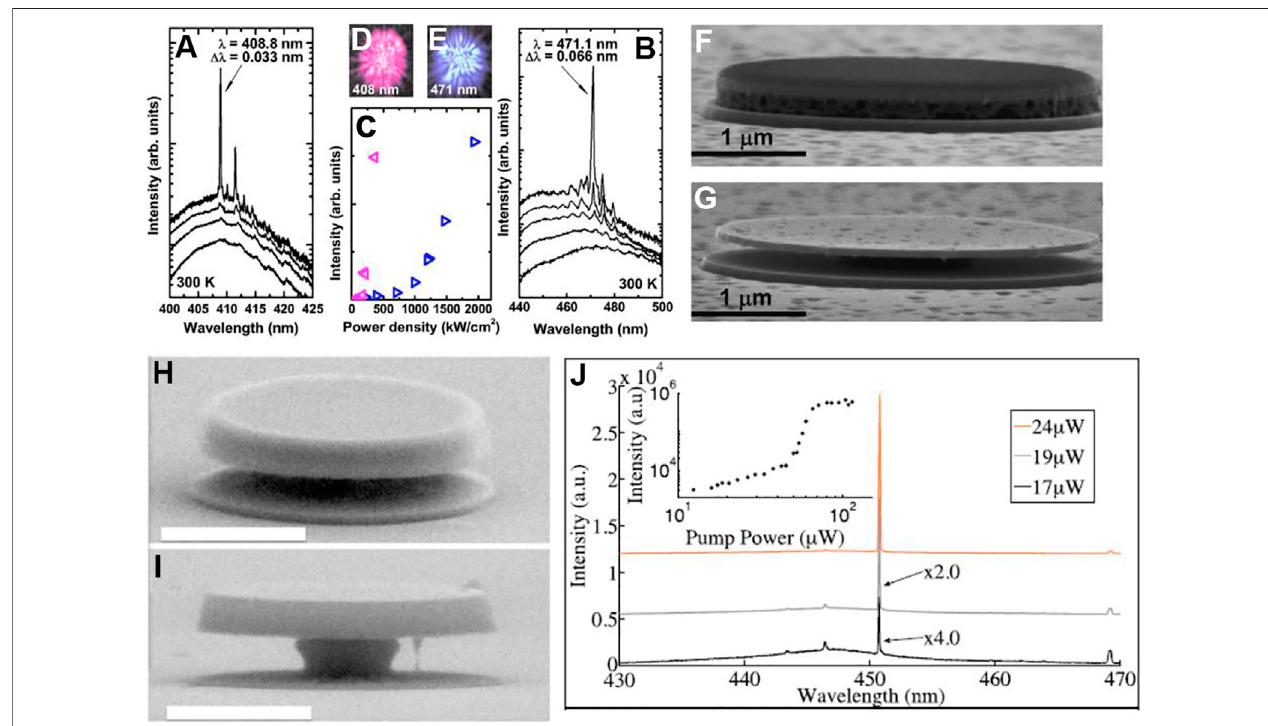
FIGURE 4 | Lasing properties of GaN microcavities (Simeonov et al., 2008), reprinted with permission © AIP Publishing (Simeonov et al., 2008). Lasing spectra of GaN microcavities with (A) low and (B) high In content. (C) Threshold curves of GaN microcavities. Optical microscopy images with false color (D,E) . SEM images of AlGaN (F) before and (G) after removal of the oxidation sacri fi cial layer. Lasing properties of fl oating GaN microstructures with a quantum well layer (Woolf et al., 2014): (H,I) SEM images; (J) lasing spectra with the threshold curve as an inset image, reprinted with permission © PNAS Publishing (Woolf et al.,